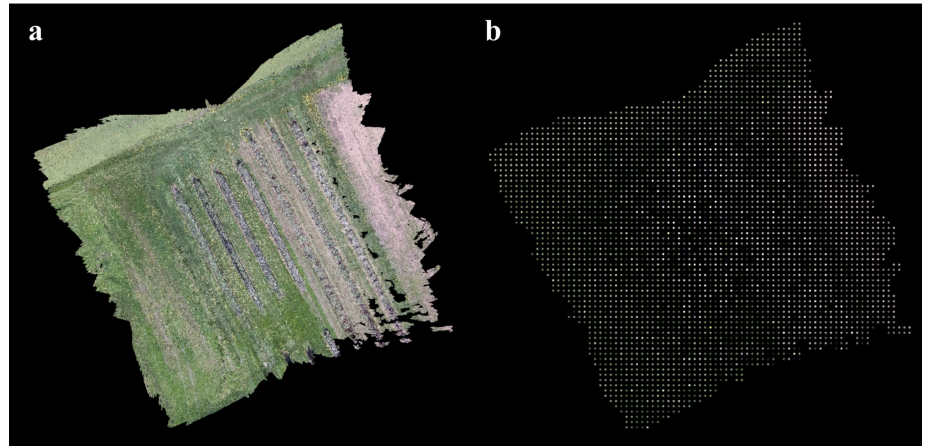
Figure A2. A top-view example of the downsampling process for the raw orchard point cloud by a